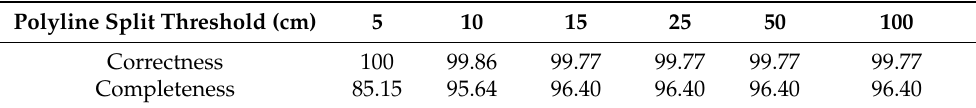
Correct. Table 5. Completeness and correctness percentage for different values of minimum length for lines (MLL) and distance between line end nodes (DBLEN). Table 6. Completeness and correctness percentage for different values of the maximum angular difference in tilt and azimuth between lines. DBLEN Correct.